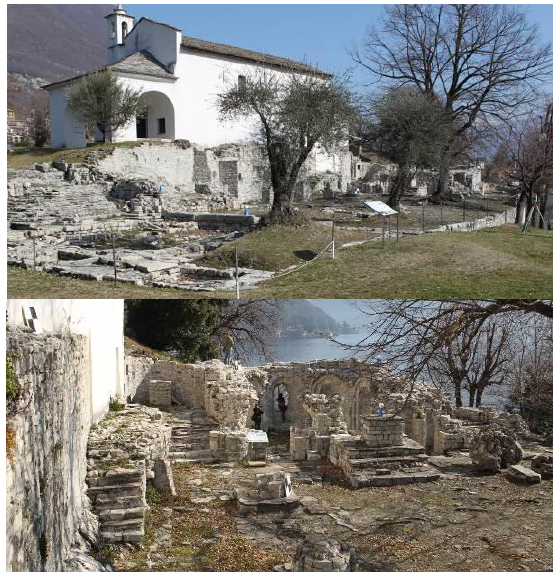
Fig. 3. The church of St. Giovanni with the archaeological remains of the basilica of St. Eufemia in close